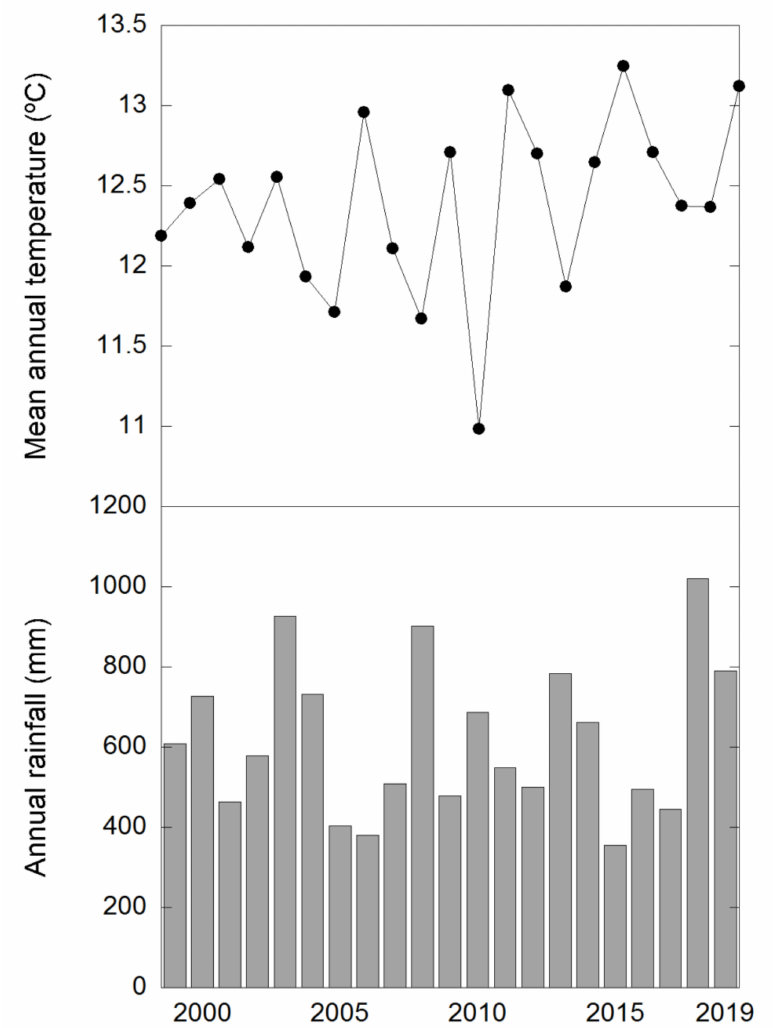
Figure A2. Mean annual temperature and annual rainfall values of the study site during the overall duration of the